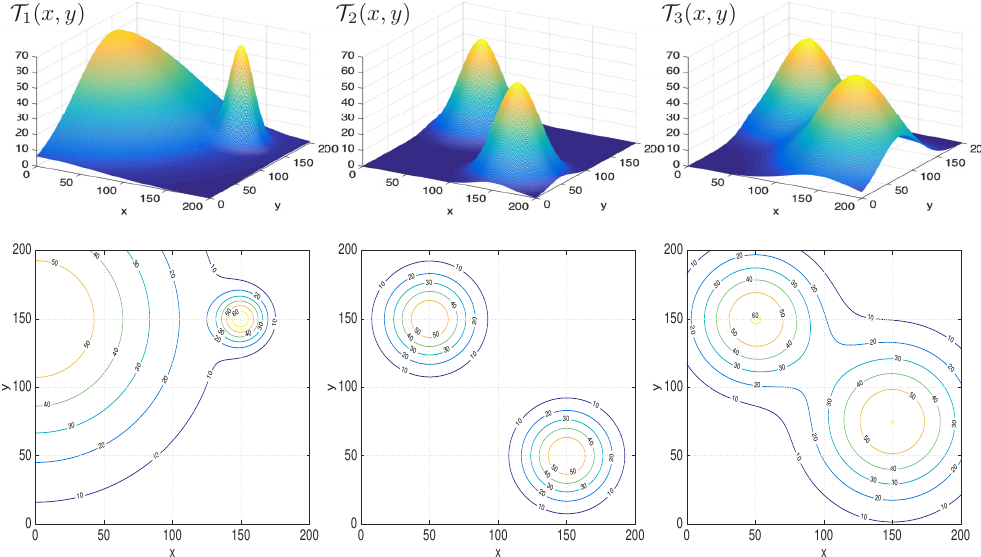
( x , y ) given by (15) with h 1 = h 2 = 60 and ( left ) x 1 = 0, y 1 = 150, Figure 3. Topographies for T γ 1 = 10,000, x 2 = 150, y 2 = 150, γ 2 = 300 (topography for Scenario 2.2), ( middle ) x 1 = 150, T 1 y 1 = 50, γ 1 = 1000, x 2 = 50, y 2 = 150, γ 2 = 1000 (topography for Scenario 2.3), ( right ) x 1 = 150, T 2 y 1 = 75, γ 1 = 3000, x 2 = 50, y 2 = 150, γ 2 = 2000 (topography for Scenario 2.4), shown in each case T 3 as three-dimensional plots ( top ) and as contour maps ( bottom